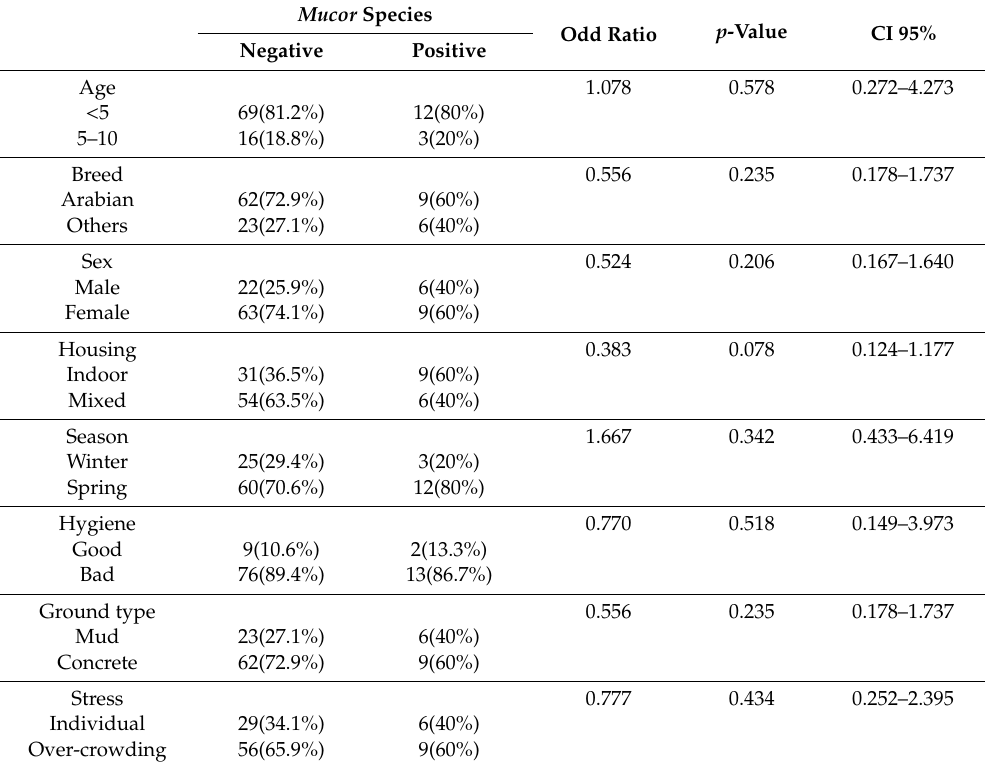
Table 6. Risk factors of Mucor .